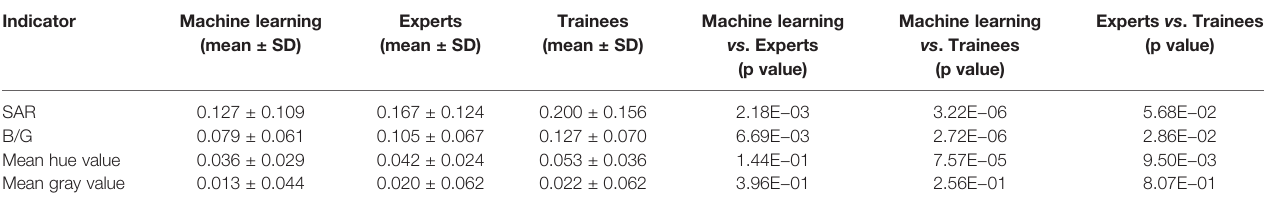
TABLE 5 | Differences in CV values of quantitative methods among the three groups.